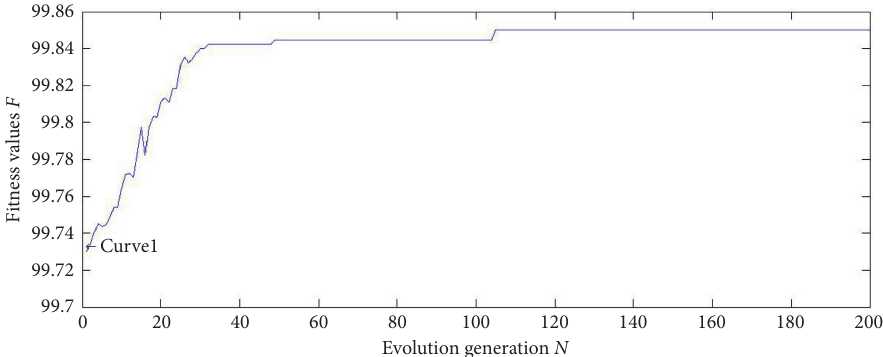
Figure 3: Optimal fitness value of each iteration of DPAGA